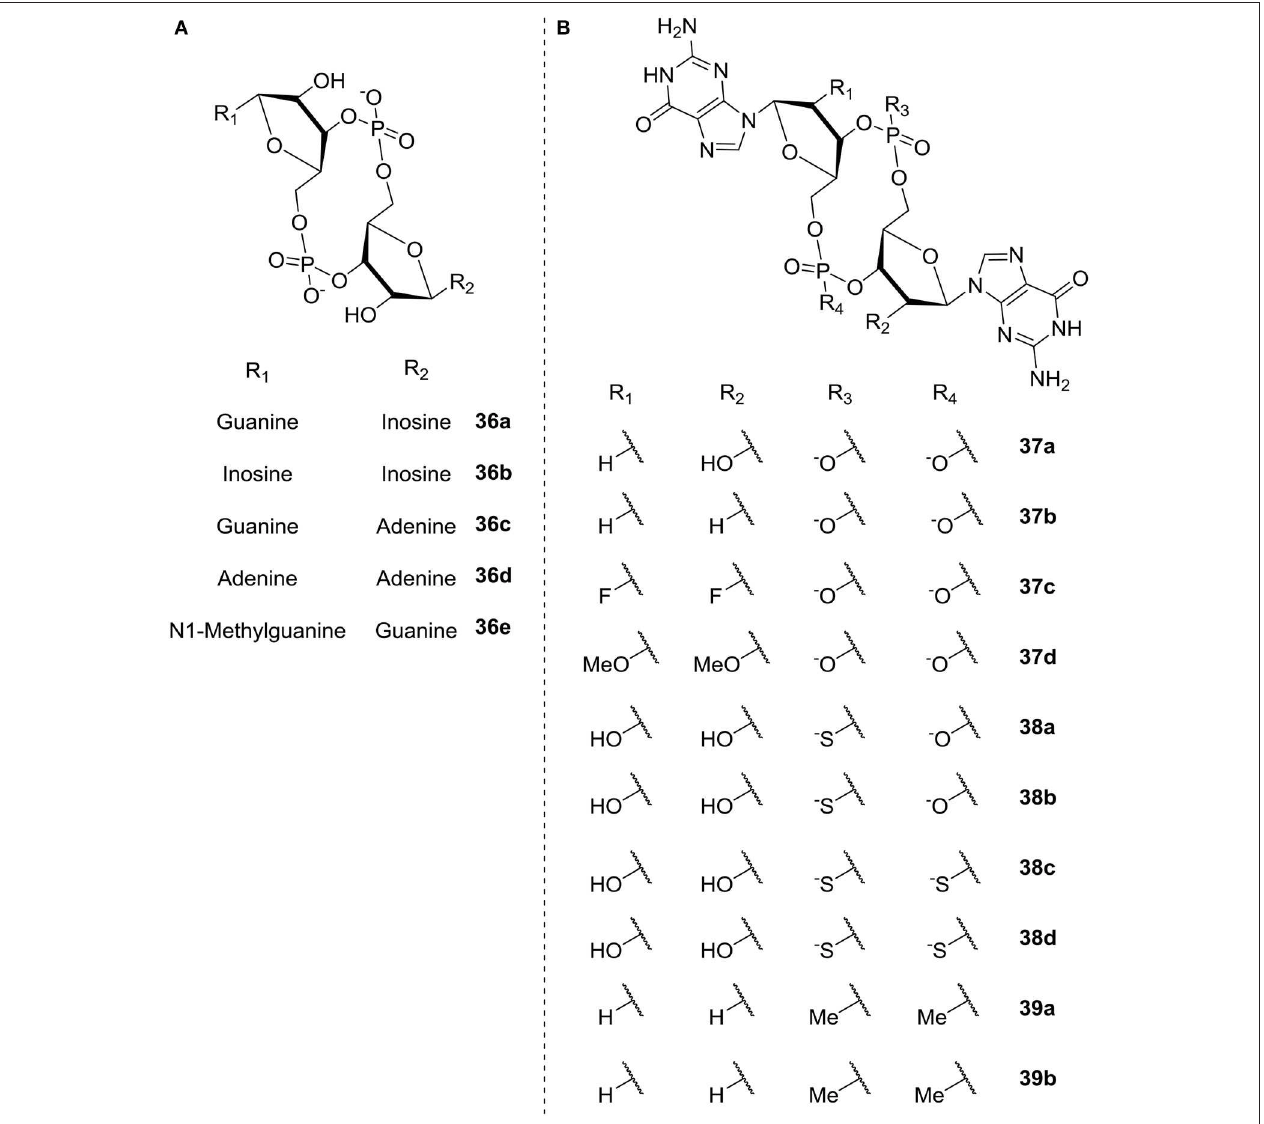
FIGURE 9 | C-di-GMP analogs studied by Shanahan et al. (2013) (A) base modification ( 36a-e ) (B) ribose modification ( 37a-d ), phosphate modification ( 38a-d ), both ribose- and phosphate-modification ( 39a-b